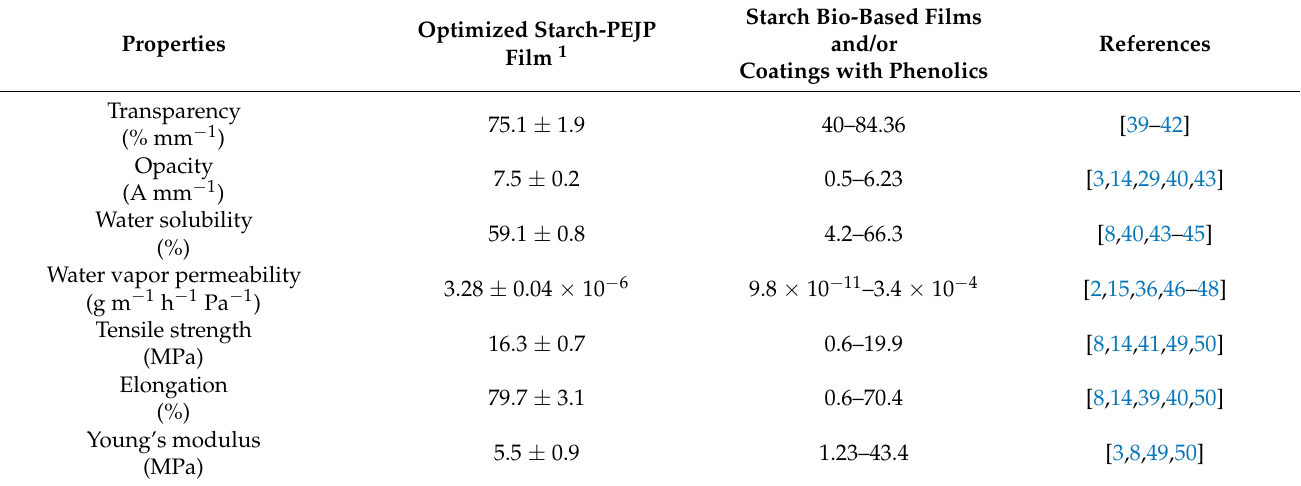
Table 2. Properties of the starch-PEJP compared to other similar starch bio-based films and